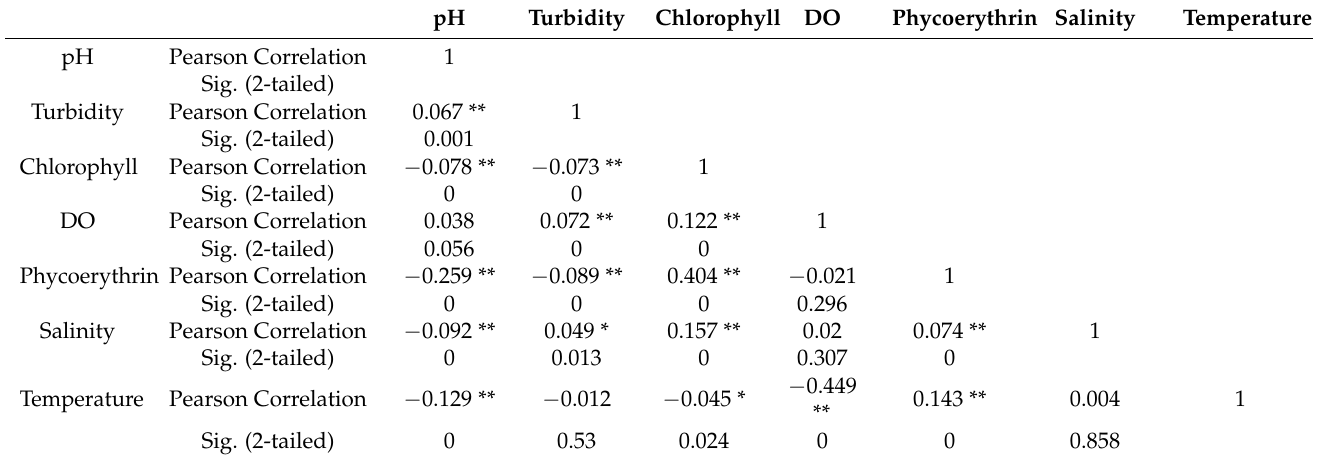
Table 9. Pearson correlation matrix based on LT